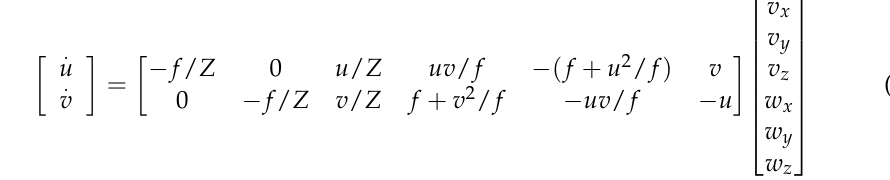
Figure 10. Workpiece landmarks for peg-in-hole. The relationship between the motion of the camera and the pixels in the image is given by the image Jacobian matrix: